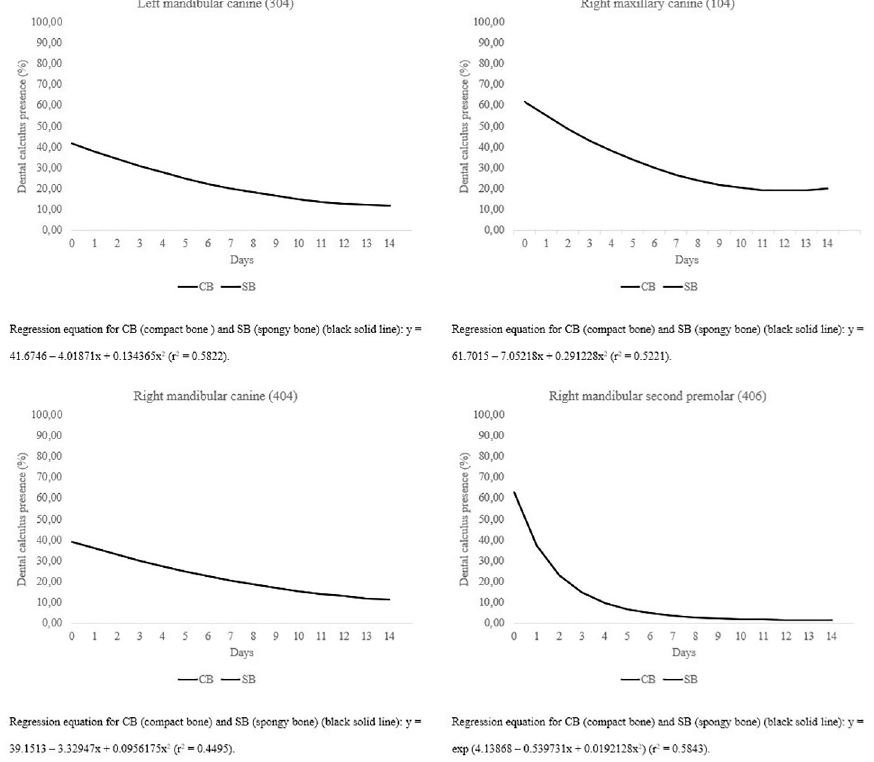
Fig 5. (a) Effect of time on dental calculus removal on teeth 304 and 104 during the treatment period in adult Beagle dogs receiving different types of autoclaved beef bones. (b) Effect of time on dental calculus removal on teeth 404 and 406 during the treatment period in adult Beagle dogs receiving different types of autoclaved beef